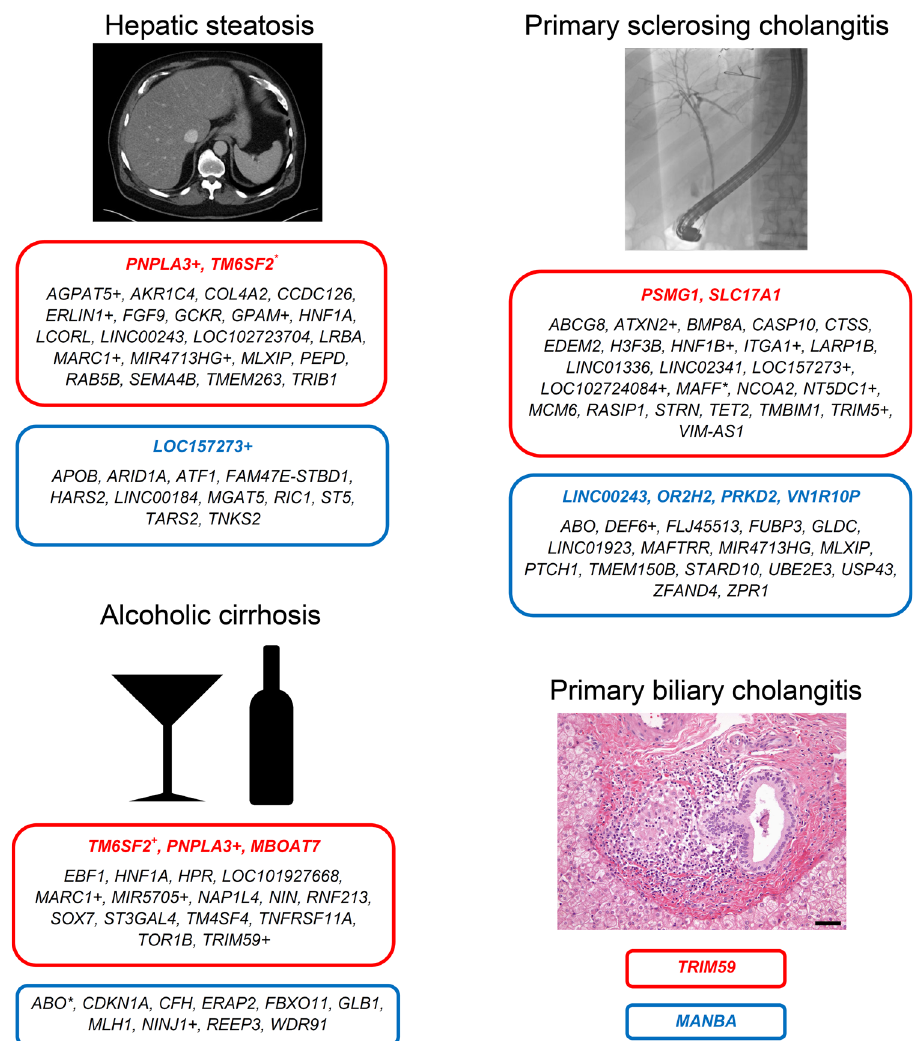
Fig. 5 Associations of liver enzyme-increasing genetic variants on liver diseases. The nearest gene to each variant is depicted. Red text indicates that the liver enzyme-increasing allele increases risk of that disease, while blue text indicates that it lowers risk of that disease (Bonferroni-corrected). Black text indicates a trend toward a signi fi cant effect ( p < 0.05). When two or three variants <1 MB apart are associated with different liver enzymes are also associated with a liver trait, this was considered a single genetic locus and the variant with the lowest p -value for its respective liver enzyme was used. These variants are highlighted with * indicating that the locus had opposite directions of association on the liver enzymes, or with + indicating that the locus had the same direction of association on the liver enzymes. Hepatic steatosis is de fi ned as negative computed tomography-measured liver attenuation, so that an allele that is associated with increased liver attenuation would be associated with decreased hepatic steatosis, and vice versa. Scale bar length is 50 micrometers. The primary biliary cholangitis micrograph is courtesy of Dr. Henry Appelman at University of